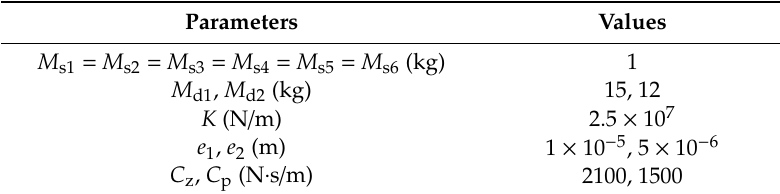
Table A1. The model parameters of rotor shaft.